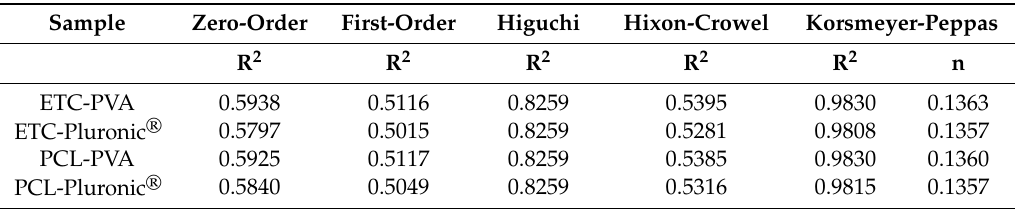
Table 2. Models applied to the release profiles in polymeric